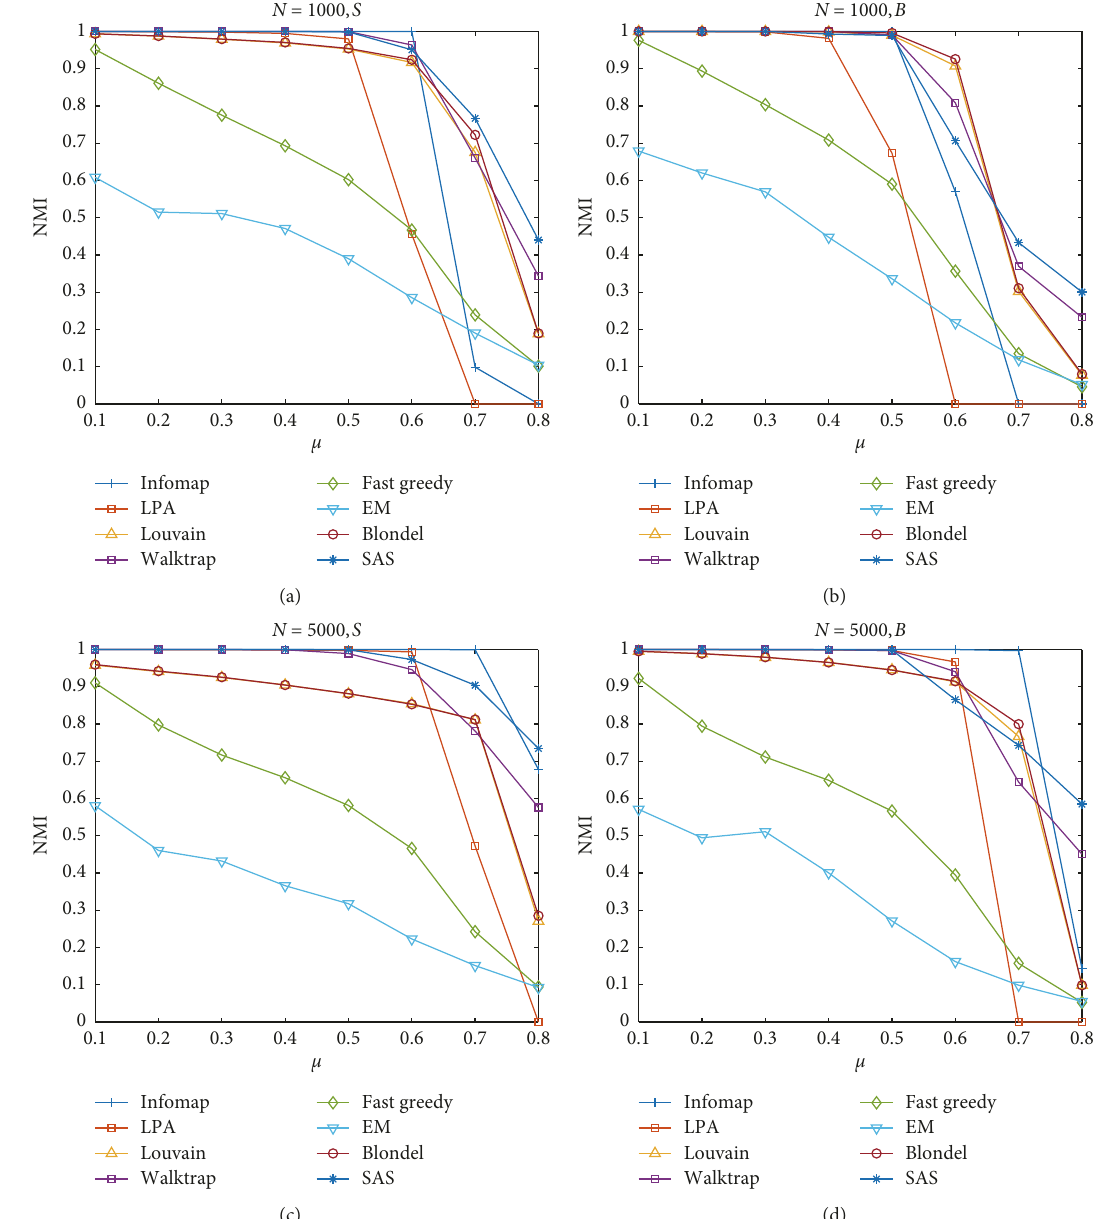
Figure 6: Community detection on LFR networks. For each combination of parameters, 100 networks have been generated. And for each network, the community detection methods Infomap, LPA, Louvain, Walktrap, Fast greedy, EM, and Blondel have been executed. The communities detected have been compared by computing the normalized mutual information (NMI). The parameters β � 3, c � 0 . 9, and ρ � 0 .